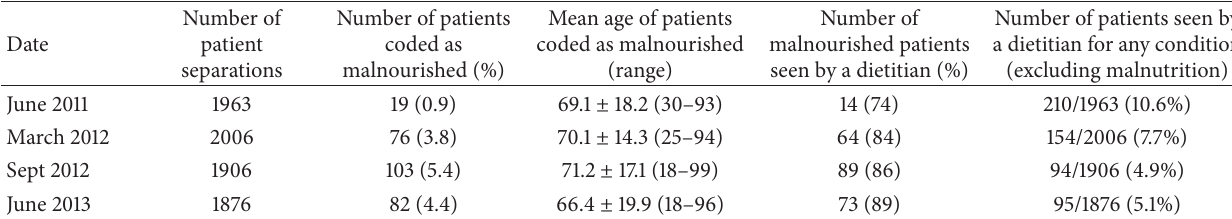
Table 3: Medical history audit of patients assessed as